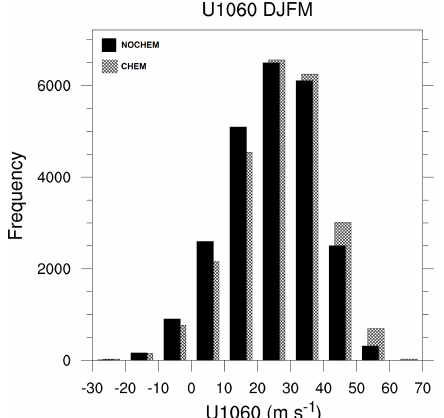
Figure 2. Histogram of daily values of zonal mean zonal wind at 10hPa and 60 ◦ N in December–March for CHEM and NOCHEM. The mean of the CHEM and NOCHEM zonal mean zonal wind values are 26.1 and 24.4ms − 1 , respectively. The right tail of the CHEM distribution is longer, indicating more days of a particularly strong polar vortex. Table 1. Summary of sudden stratospheric warming (SSW) and strong polar vortex (SPV) events in 200-year year 2000 time